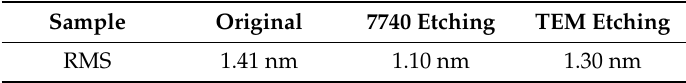
Table 2. Roughness of several types of glass surfaces.